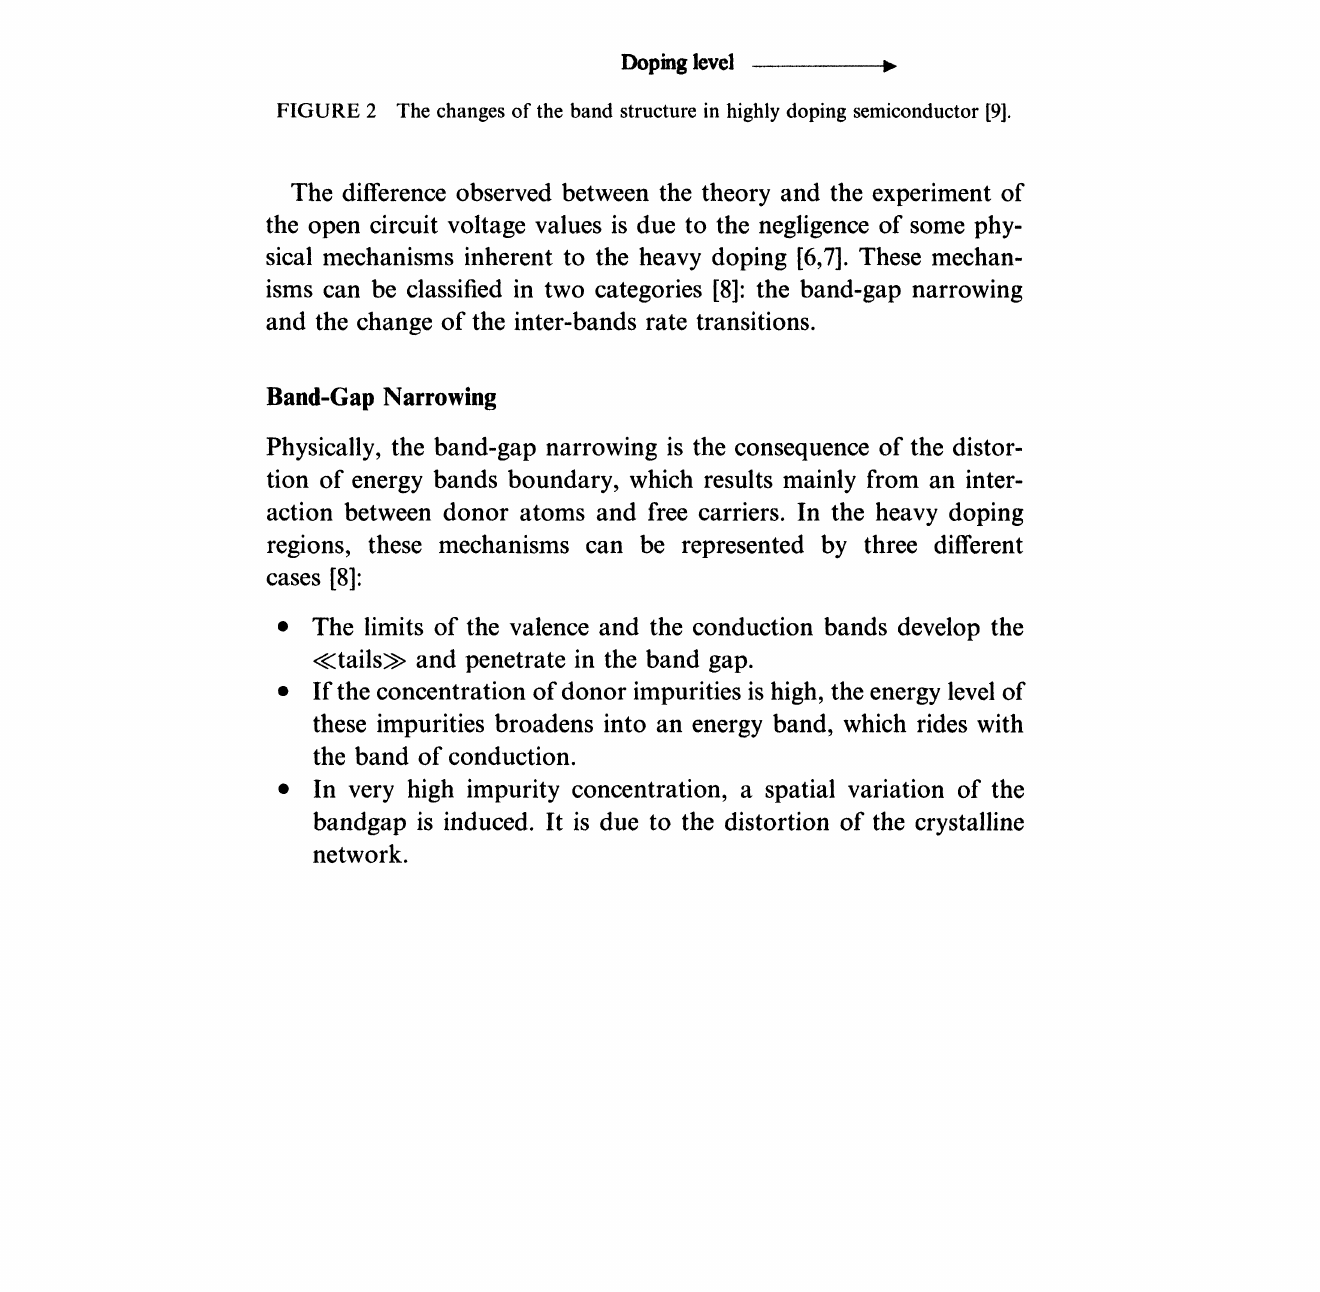
Doping level FIGURE 2 The changes of the band structure in highly doping semiconductor